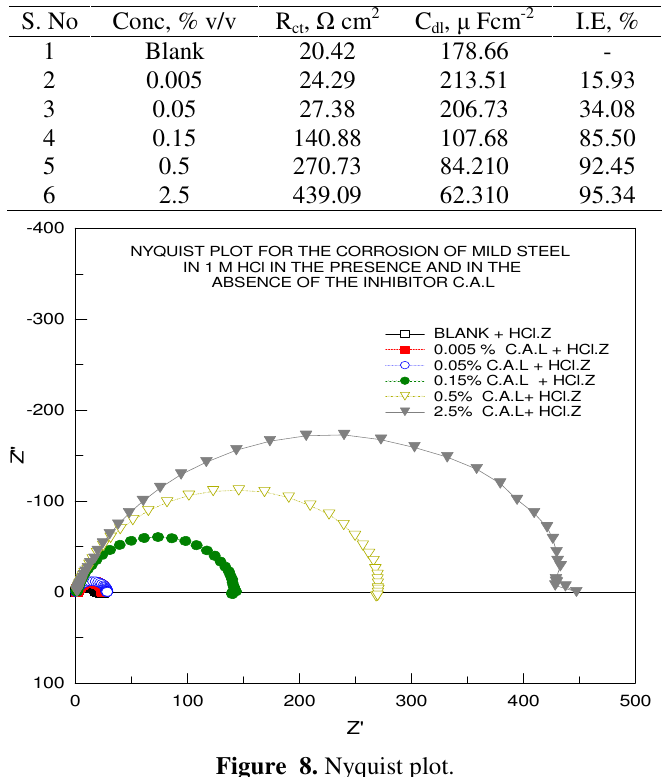
Table 6. Impedance parameters for the corrosion of mild steel in 1 M HCl containing different concentrations of CAL.